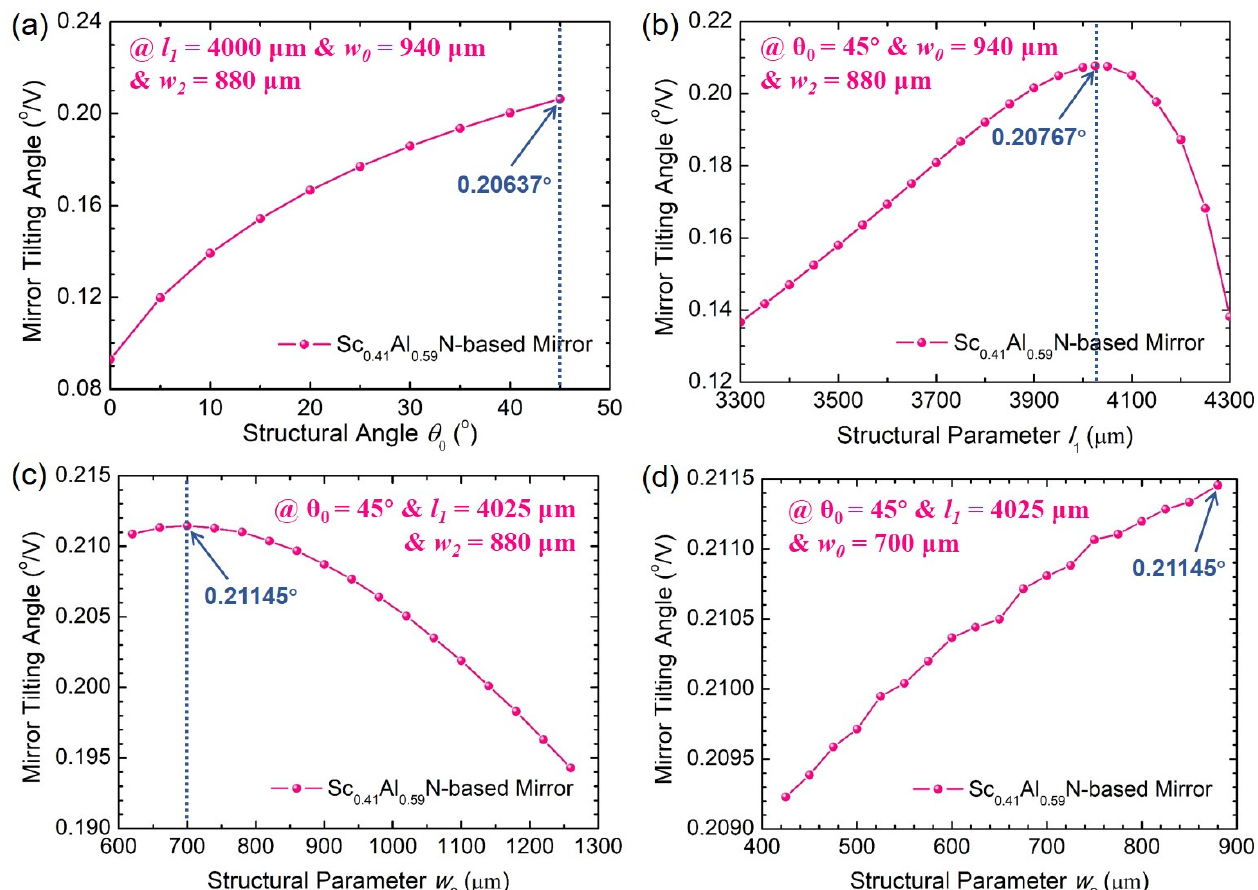
Figure 6. The dependence of the static tilting angles on the structural parameters: ( a ) θ 0 , ( b ) l 1 , ( c ) w 0 and ( d ) w 2 .